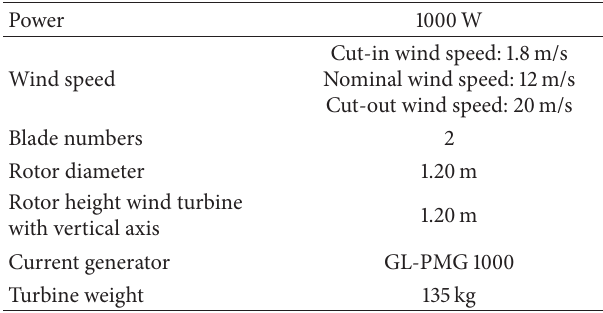
Figure 1: Helical rotor shape tested in aerodynamic tunnel. Table 1: Technical characteristics of wind turbine with vertical